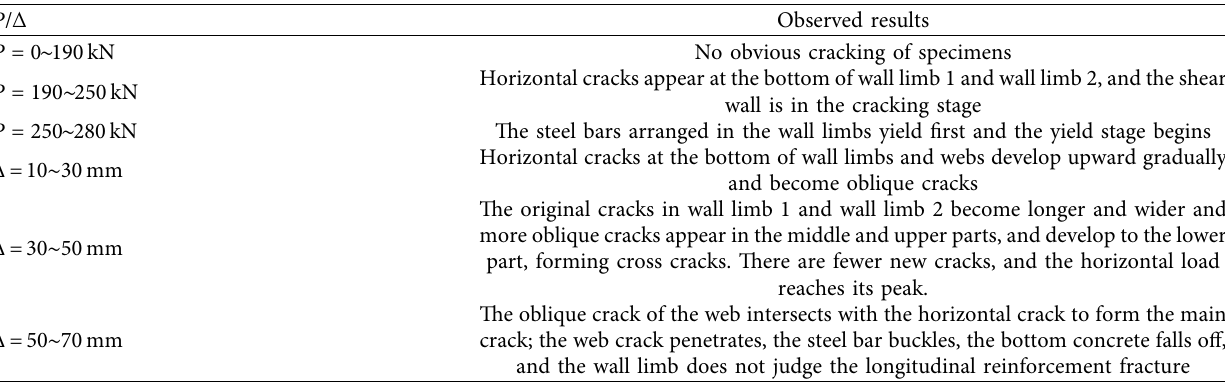
Table 4: Experimental phenomena of